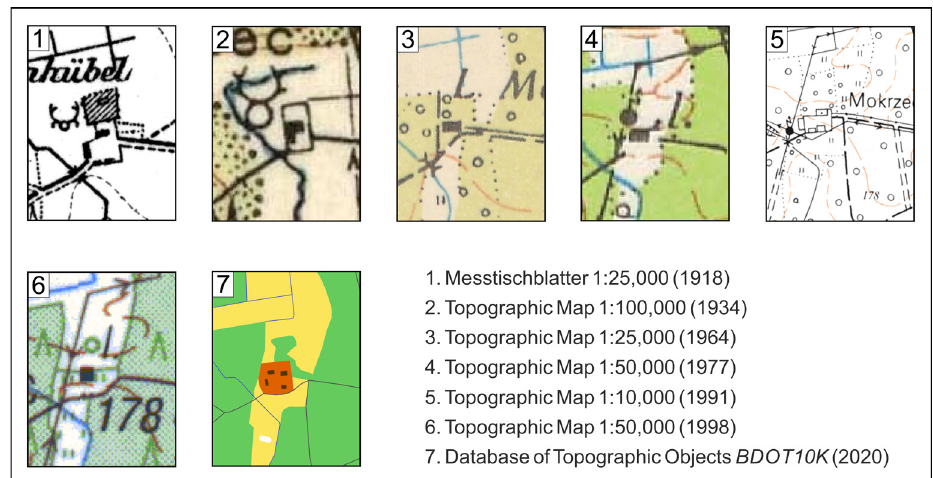
Fig. 3. Presentation of buildings on selected maps and BDOT10k